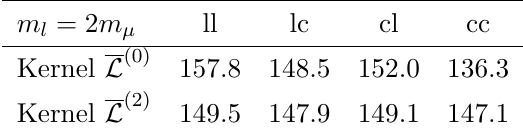
Table 4 . Results for a LbL in units of 10 − 11 from the lepton loop of mass m l = 2 m µ obtained with µ Method 1 by extrapolating the lattice results displayed in figure 10 to the continuum. Two different kernels and four different discretizations of i b Π are used. The exact result is a LbL